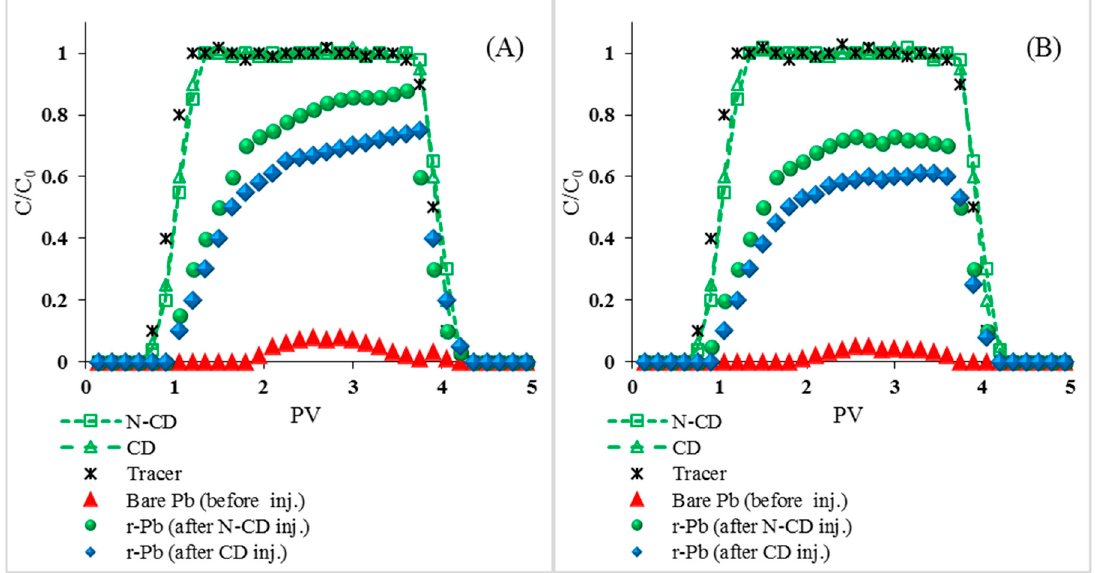
Figure 4. Breakthrough curve (BTC) of N-CD, CD, Bare Pb, released Pb (r-Pb) and tracer: NaCl ( A ), CaCl 2 ( B ). All experiments were performed in C 0 (N-CD/CD): 50 mg·L − 1 , C 0 (Pb): 10 mg·L − 1 , pH6, rate.